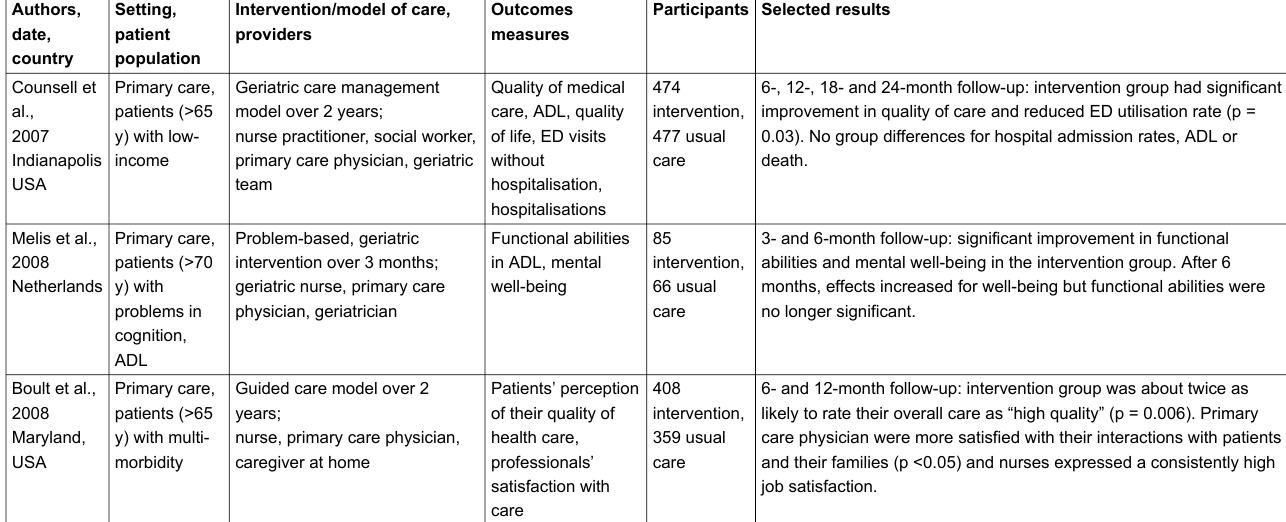
Table 1 Abbreviations: ADL= Activities of daily living/ED = emergency department/ y = years of age/ TIA = transient ischaemic attack/CI = confidence interval Authors,